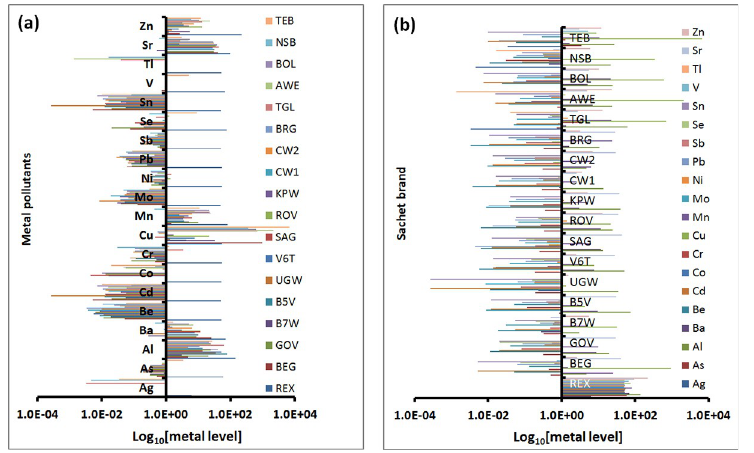
Fig 2. Semi-log plots showing pictorial overview of (a) the density of contaminating metals in each sachet brand, and (b) the frequency of detecting an individual metal across the brands. Qualitatively, REX contains the highest combination of different metals. The frequency of detecting As, Al, Ba, Be, Cd, Cr, Mn, Mo, Pb, Sb, Sn, Sr and Zn in all the brands is relatively higher than of detecting Ag, Co, Cu, Ni, Se, V and Tl.